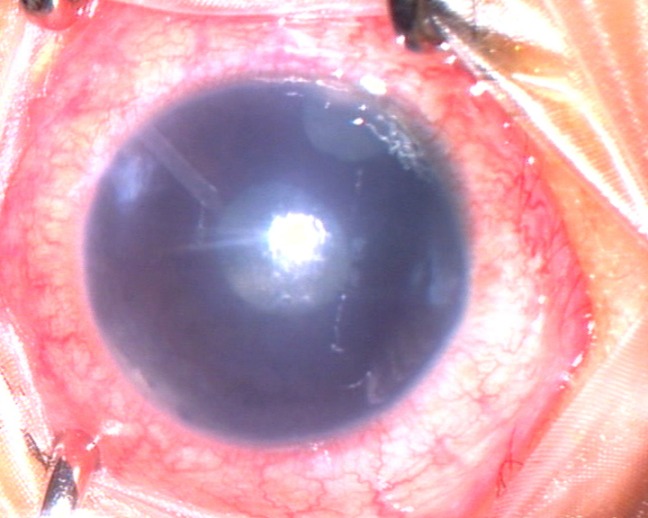
Endophthalmitis